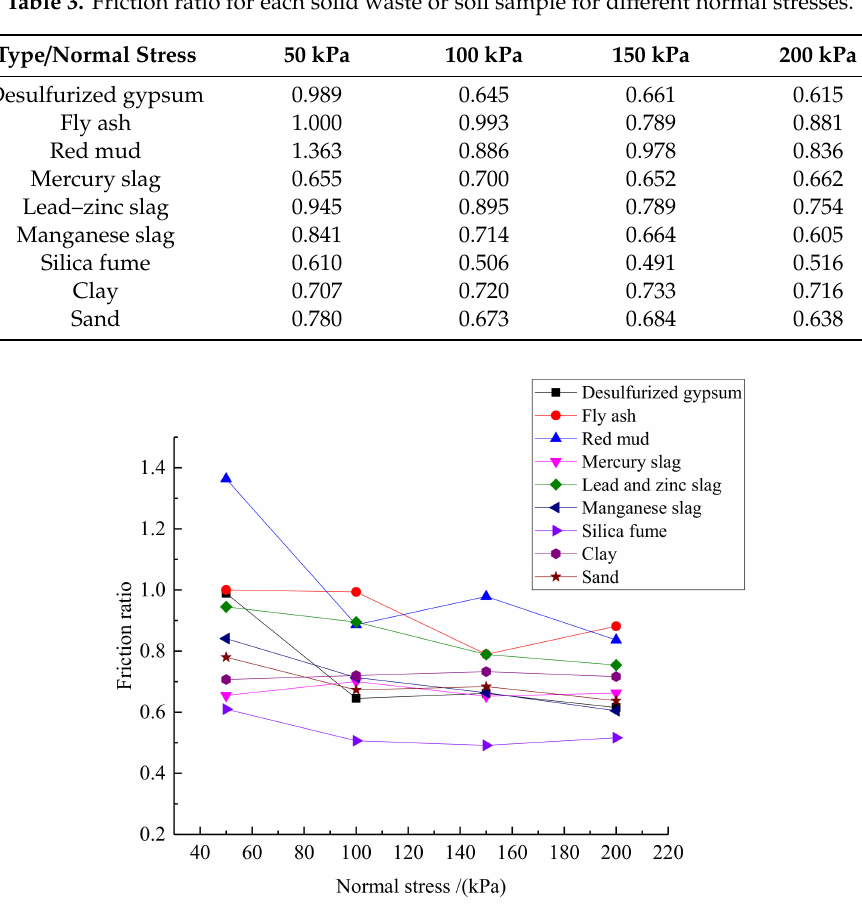
Figure 6. Evolution of the friction ratios for di ff erent solid wastes or soil